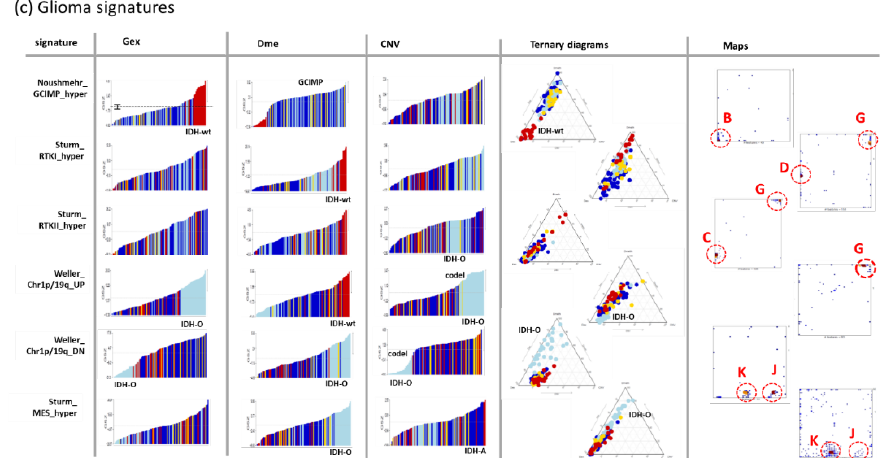
Figure A2. Sets of signature genes were characterized using ranked profiles, ternary diagrams and signature maps. ( a ) Genes from selected chromosomes are typically aberrant in gliomas, ( b ) func- tional signatures [43,56] and ( c ) signatures differentiating glioma subtypes obtained in previous studies [22,24,37]. In the profiles, the LGG samples were coloured according to the genetic groups IDH-wt (red), IDH-A (blue), IDH- A’ (yellow) and IDH -O (light blue). ( a ) Genes from the key-chro- mosomal aberration at Chr.1 and 19 (preferentially in IDH-O, partly in IDH- A’) and Chr. 7+ and Chr. 10 − (in IDH-wt and, partly, in IDH- A/A’) accumulate in specific areas of the map and reveal orchestrated changes of Gex and CNV values due to dose – response relationships in the ternary di- agrams. ( b ) Gene signatures characterizing different biological functions enrich in specific areas of the map. This is indicative of co-regulation of the involved genes which is governed partly by Dme and CNV. For example, genes related to cell cycle activity accumulate in and around spot F and show high expression in IDH-wt and IDH-O. It associates with hypomethylation and a slight copy number gain in IDH-O paralleled by hypomethylation of MYC -targets, while cycling genes are hy- permethylated in IDH-wt, thus showing the opposite methylation trend. Genes with functions in inflammatory response are downregulated in IDH-O due to their hypermethylation, a pattern, which is partly observed for G-protein coupled receptors (GPCR), thus suggesting their role in this process. Targets of the polycomb repressive complex (PRC2) and so-called low transcription factor activity genes (low TF) are mostly regulated by epigenetic mechanisms in the context of differenti- ation and development of healthy tissues and cancer [43,56]. Genes from these sets split into two major populations found near opposite corners of the map, namely the lower-left one (Gex_UP in LGG) and the upper right corner (Gex_DN in LGG). This split indicates that the respective genes are affected by an LGG group specific hyper-methylation patterns which activates them either in healthy brain or in brain cancer. Conversely, so-called high-TF genes associate with regulatory modes governed by TF-networks. They accumulate in regions of increased proliferative activity ob- served for MYC -targets. ( c ) Glioma-related signatures were taken from [22,24,37,41]. They show mostly pronounced enrichment in spot areas and clearly associate with group-wise up- and/or down-regulation in the different omics domains. They were adequately extracted from glioma ex- pression data sets. Therefore, these signatures give rise to the spread of the LGG along the Gex axis of the ternary diagram, however with segregation between subtypes, e.g., between IDH-A and IDH- O.